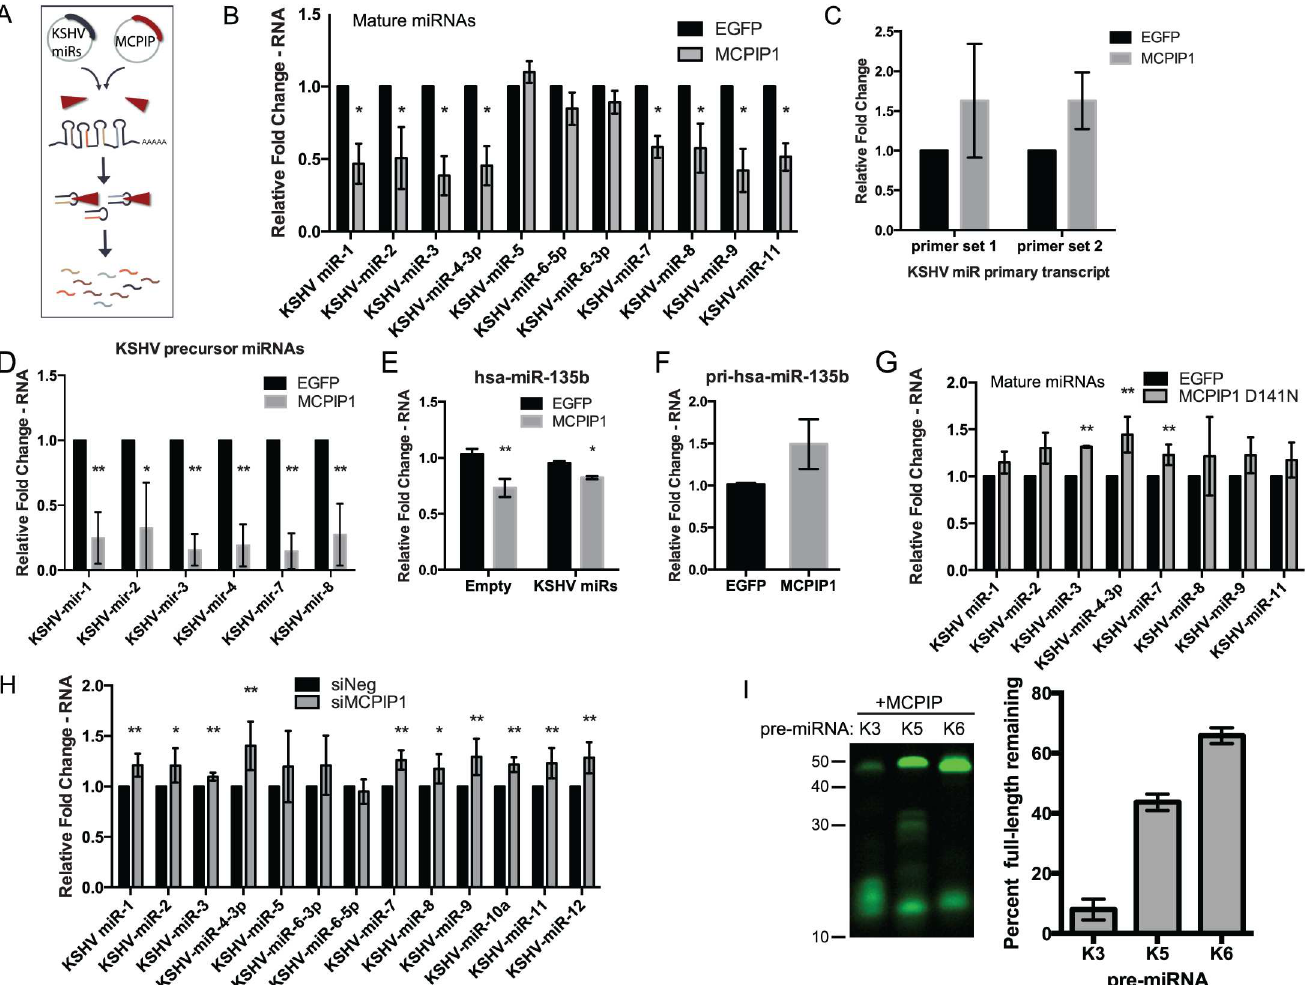
Fig 2. MCPIP1 represses mature miRNA expression by cleaving pre-miRNA. (A) Experimentaldesignschematic for Fig 2B–2G. (B) 293 cells were transfected with a KSHV miRNA expressionvector and a MCPIP1 expressionplasmid. Expression of mature miRNA was measuredusing qPCR assays. Results are shownrelative to RNU48and normalized to the cells transfected with KSHV miRNA expressionvector and the EGFP control. N = 3. (C) Expression of the KSHV miRNA primary transcript was measuredfrom the same RNA samples as in (B) by qPCR using two different SYBR green primer sets. Results are shownrelative to GAPDH, N = 3. (D) RNA from (B) was assayed for expressionof KSHV pre-miRNAs using qPCR. Results are normalized to U6 and the EGFP control, N = 3. (E) Expression of hsa-miR-135b was measuredfrom the same RNA samples as in (B) and normalized to the empty vector controls, N = 3. (F) Primary transcript level of hsa-miR-135b was measuredusing qPCR as in (B). Results are shown relative to β -actin and normalized to empty vector controls, N = 3. (G) 293 cells were transfected with a KSHV miRNA expressionvector and an RNase dead, MCPIP1 D141N expressionplasmidas in (B). N = 4. (H) BCBL-1 cells were transfected with siRNA to MCPIP1 followedby isolationof newly synthesized labeled RNA. cDNA was obtainedand mature KSHV miRNA expressionwas measured by qPCR. Results are shownrelative to RNU48and normalized to the siNeg control. N = 3–5. (I) In vitro cleavageassay for pre-KSHV-mirs-3, 5, and 6, synthesized with 5’IRD800CWN labels.Pre-miRNAs were incubated with MCPIP1 and assayed for degradation. N = 3. The percent of full-lengthpre-miRNAsis shown in the accompanying graph. For all graphs, results are shown as mean ± SD (standard deviation). Significance was assessed using a Student’s t test, * p (cid:20) 0.05, ** p (cid:20) 0.01. Numerical data can be found in S1 Data.